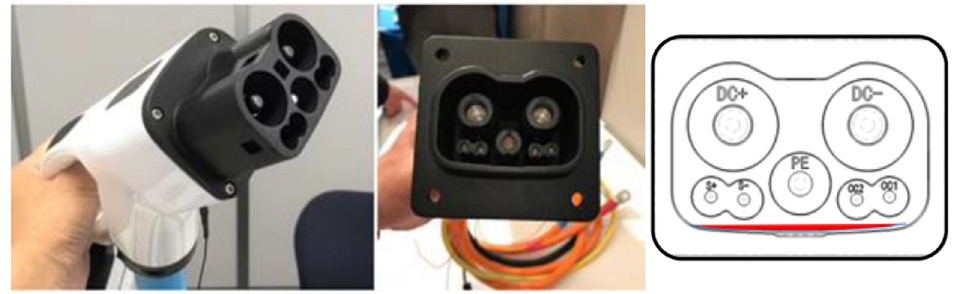
Figure 25. The ChaoJi coupler: EV Plug ( Left ), Inlet ( Middle ), and Inlet pinout ( Right ).